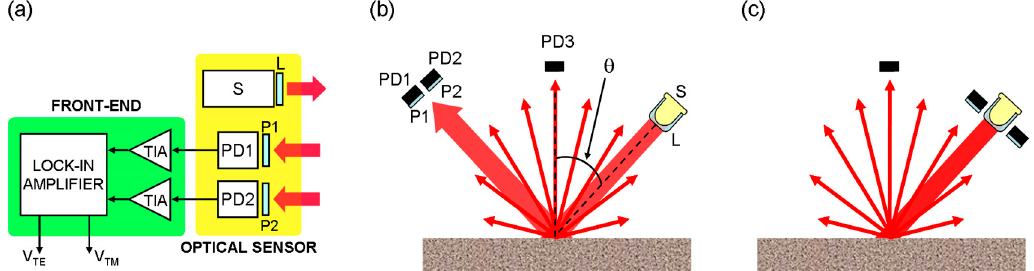
Figure 1. Block diagram and set-up. ( a ) Block diagram of the sensor. The radiation from the LED (S) was collimated by a lens (L) and impinged on the surface under investigation. After being reflected/scattered, it was detected by two photodiodes (PD1 and PD2). Two polarizers (P1 and P2) selected the horizontal and vertical polarization components. Two trans-impedance amplifiers (TIA) and the lock-in amplifier converted the optical signals into two voltage levels ready for the signal processing. ( b ) θ –2 θ configuration. The incidence angle θ was referred to the surface normal and a third photodiode (PD3) was used to measure the unpolarized scattering. ( c ) Backscattering configuration. The set-up was analogous to ( b ), but both photodetectors collecting the polarized scattering were mounted on the same side of the source.